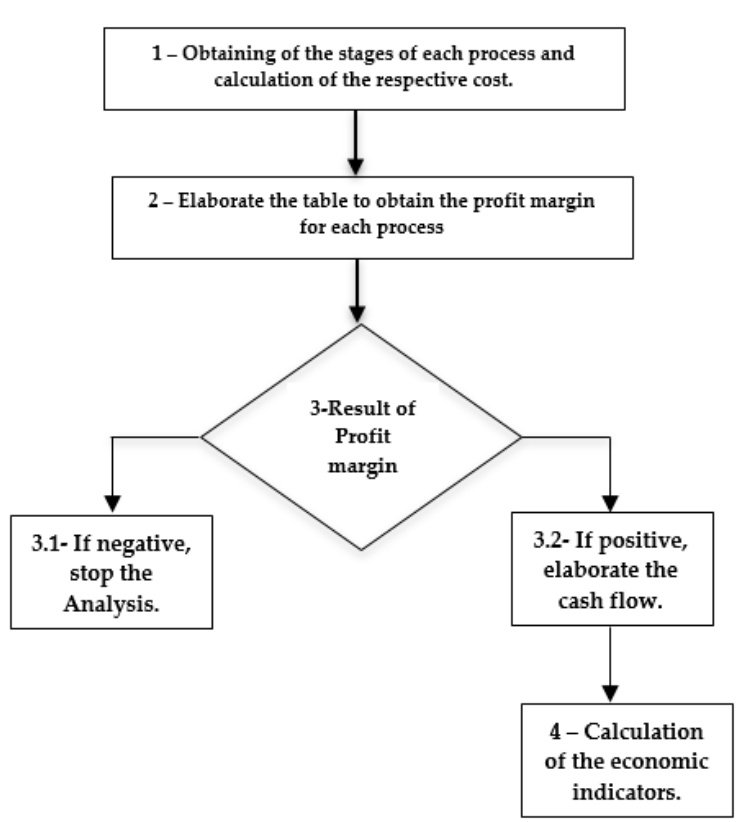
Figure 1. Methodology used to accomplish the economic feasibility assessment.